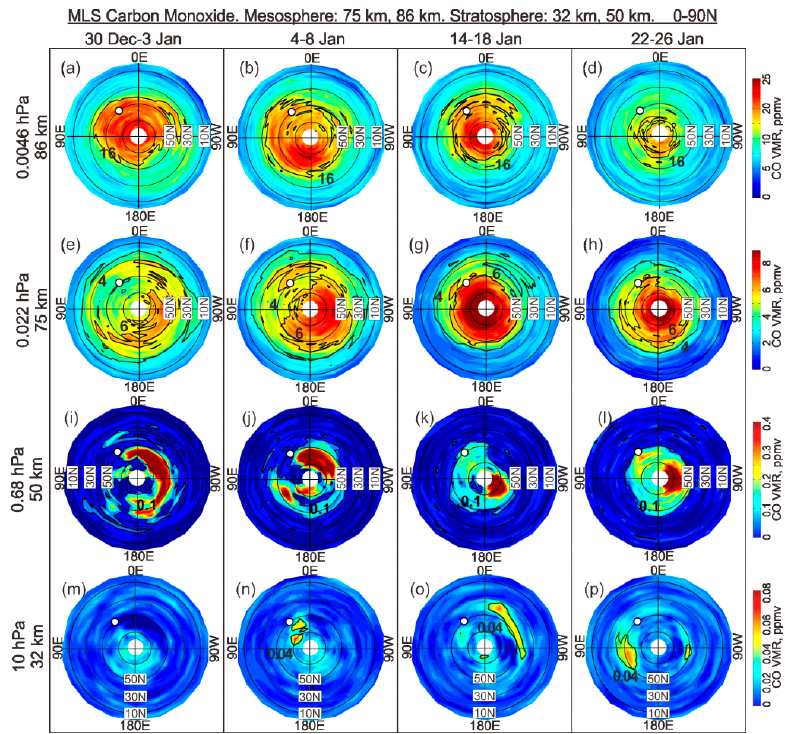
Figure 8. The 5-day mean CO field in the NH stratosphere/mesosphere (0–90°N, between 32 km and 86 km) from the MLS measurements [42] before ( a , e , i , m ), during ( b , f , j , n ) and ( c , g , k , o ), and after ( d , h , l , p ) the SSW2 in 2019. The white circle shows the location of the MWR Kharkiv site relative to the high and low CO content areas, which are separated by black contours. Note that Kharkiv fell under the high CO area in the mesosphere during SSW2 ( b , c , f , g ), which was displaced relative to Kharkiv afterward ( d , h ). This displacement explains the stepwise decrease in the post-warming CO level from the MWR data in Figure 7a and from regional MLS data in Figure 7e.